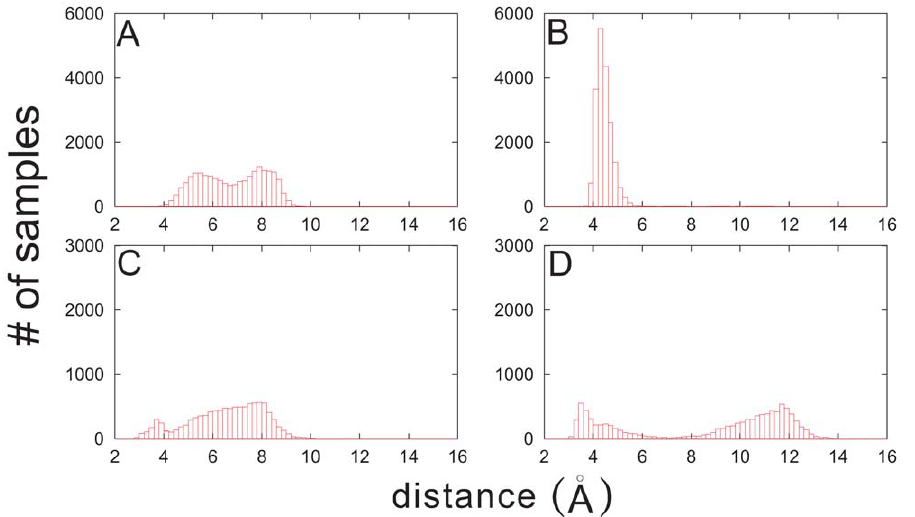
Figure 7. Histograms of number of samples as a function of atom-pair distances in the two minima of PMF. The distance between W47/ W58 of PDC109/a and the N atom of PhC in the first (2.5 A˚ v j v 3.5 A˚) (A) and second (5.2 A˚ v j v 6.0 A˚) (B) minima were calculated from the trajectory saved from the PMF calculation in the window 2.0 A˚ v j v 6.0 A˚. The corresponding results for the separation between Y60 of PDC109/a and PhC phosphate group are shown in (C) and